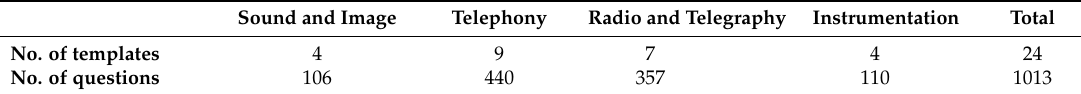
Table 2. Number of templates and questions per